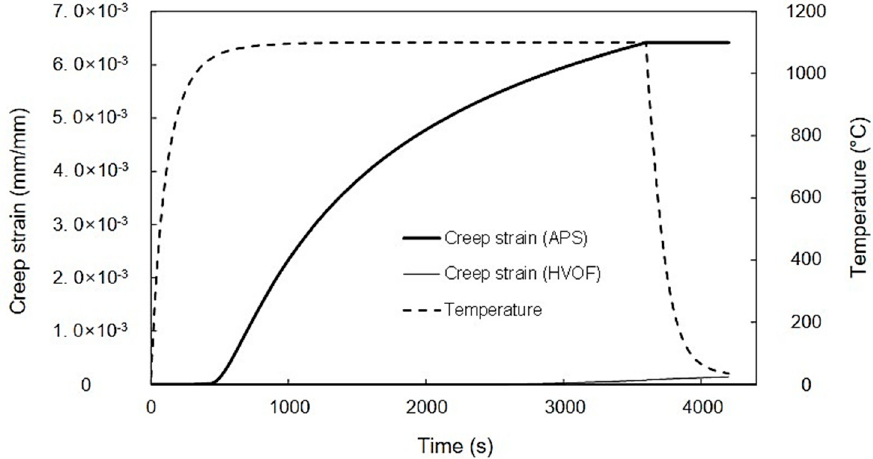
Figure 14. Comparison of creep strain of TBC with a bond coat made using APS and HVOF.